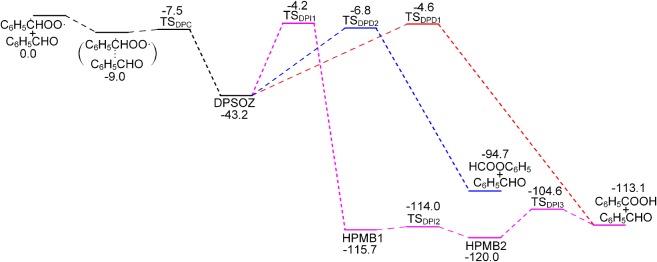
Potential energy surface (kcal mol−1) of the C6H5ĊHOO· + C6H5CHO reaction calculated at the CBS-QB3 level.